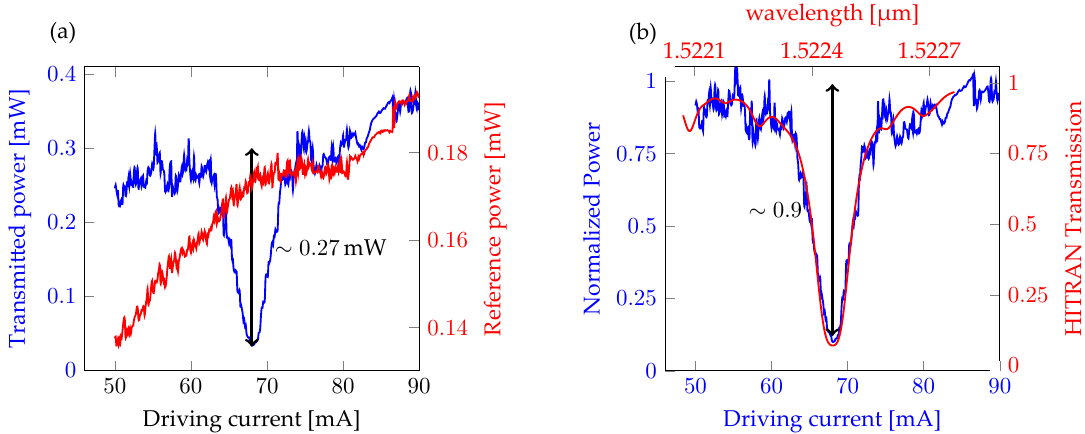
Figure 4. ( a ) Blue: Measured power through the filled hollow-core fiber (HCF) (5% ammonia). Red: Measured power on PM1. ( b ) Blue: Normalised power as a function of driving current. Red: expected transmission according to HITRAN as a function of